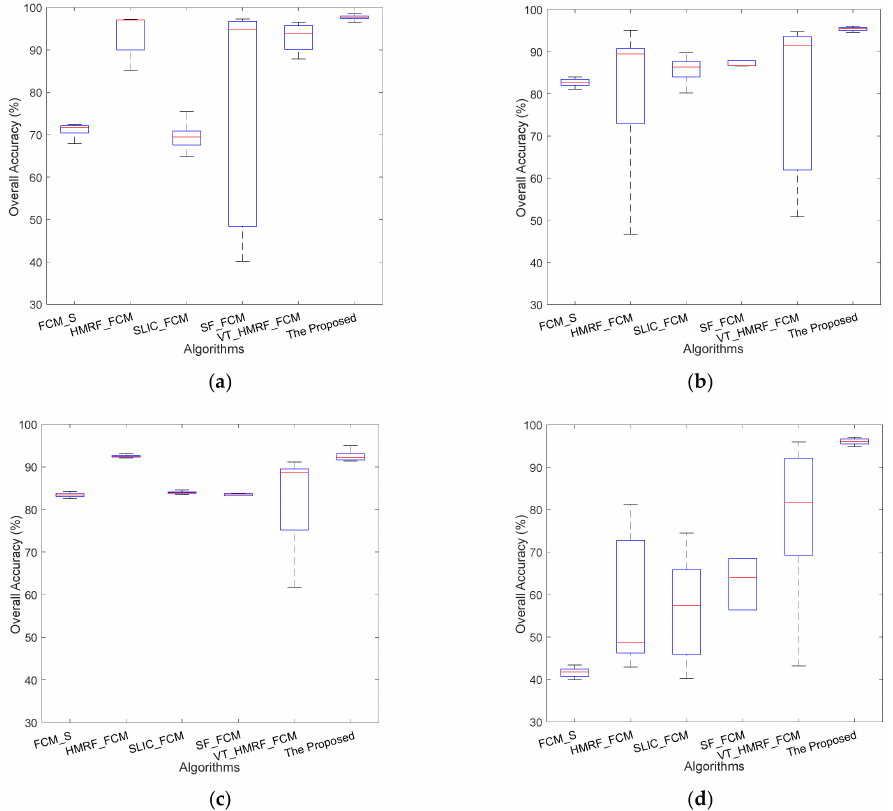
Figure 12. Box-plot of the overall accuracy of multispectral remote sensing images segmentation results based on the proposed and comparing algorithms. ( a – d ) represent images